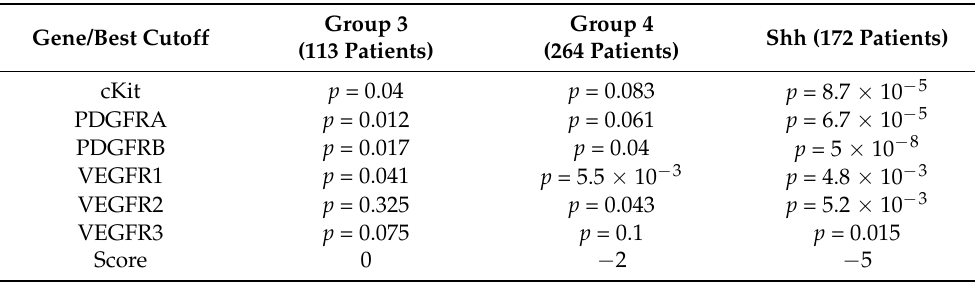
Table 4. Scoring of the association between the axitinib target expression levels and the patients’ survival